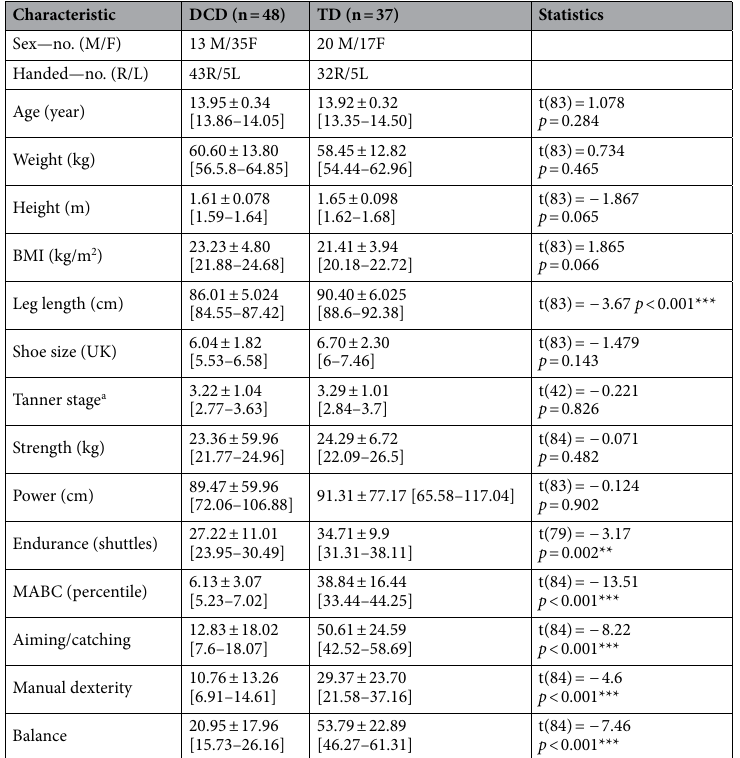
a threshold of 5 standard deviations, and a basis function of sym8 86 .